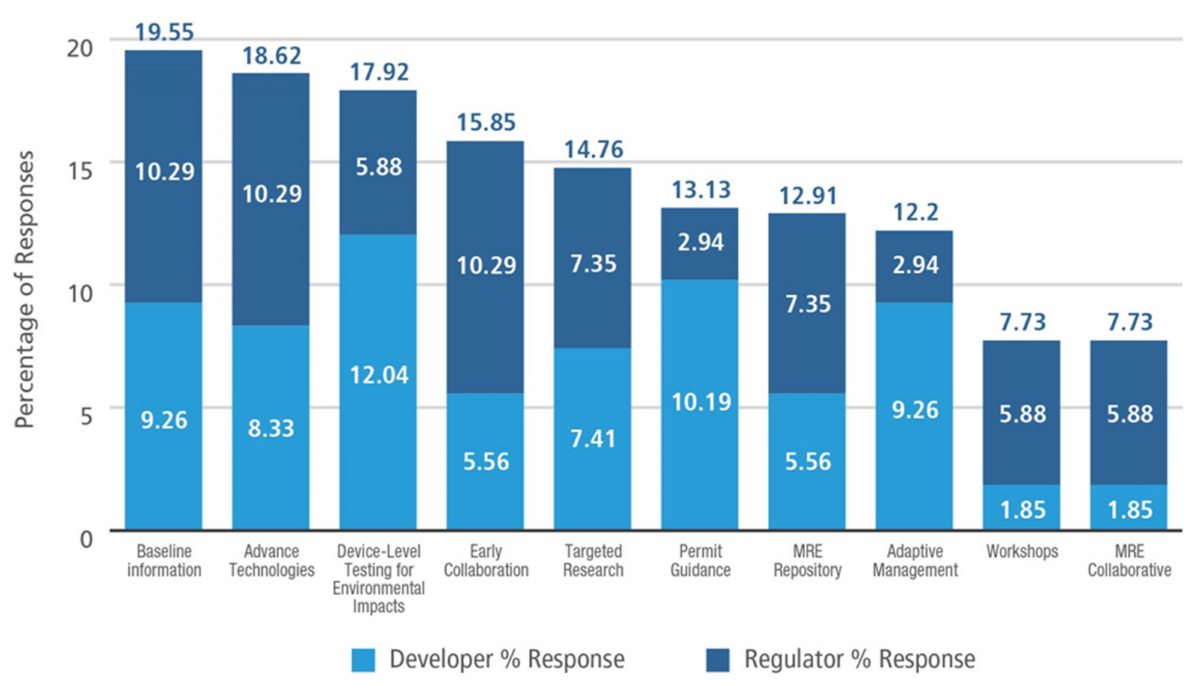
Figure 2. Action rankings at developer workshop and regulator webinar and workshop,